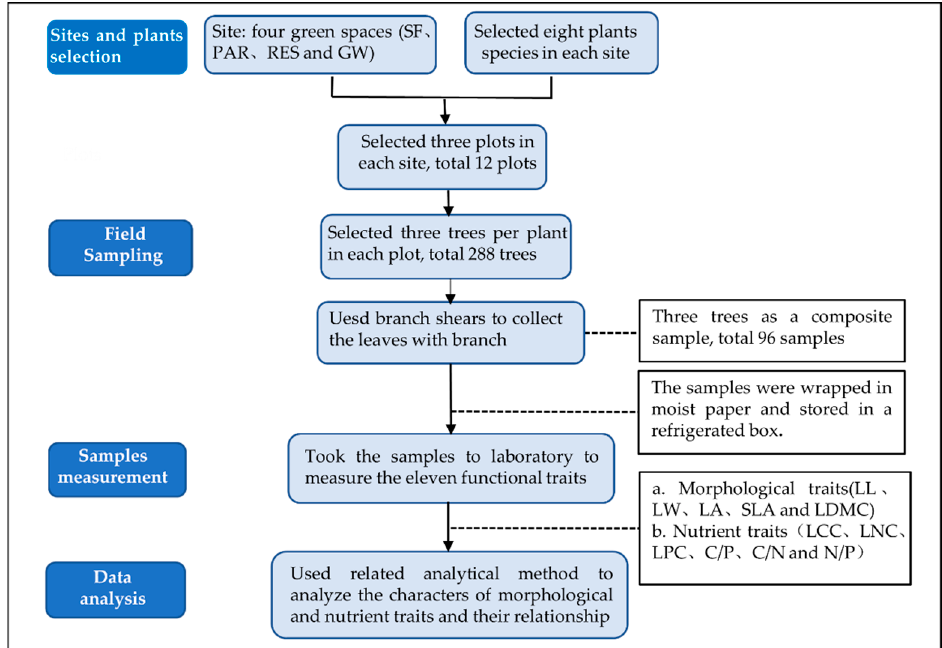
Figure 2. The flowchart of experimental method.